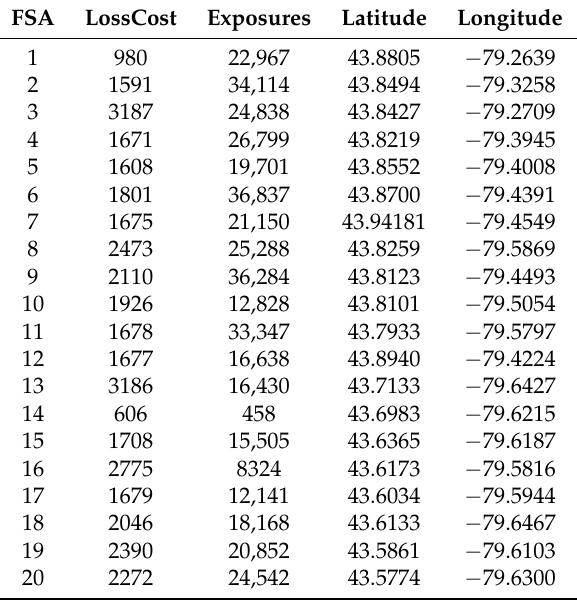
Table 1. The table summarizes data information associated with the first twenty forward sorting areas (FSA).